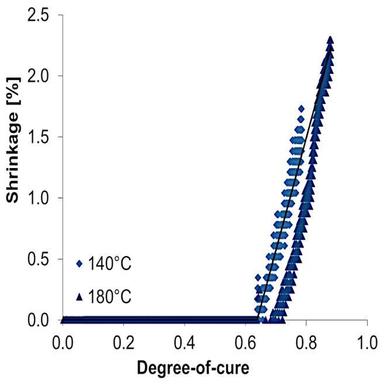
Cure shrinkage with model (solid line) of modified epoxy RS-36-1. (For interpretation of the references to colour in this figure legend, the reader is referred to the web version of this article.)